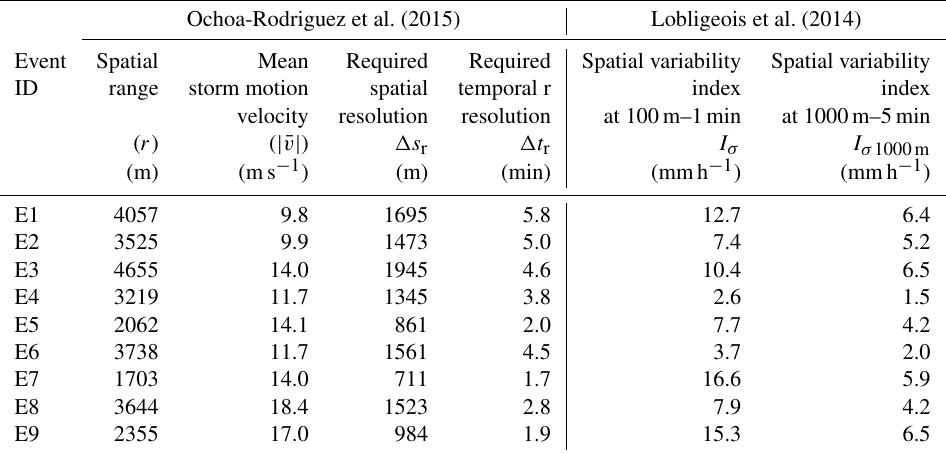
Event Spatial Mean Required Required Spatial variability Spatial variability ID range storm motion spatial temporal